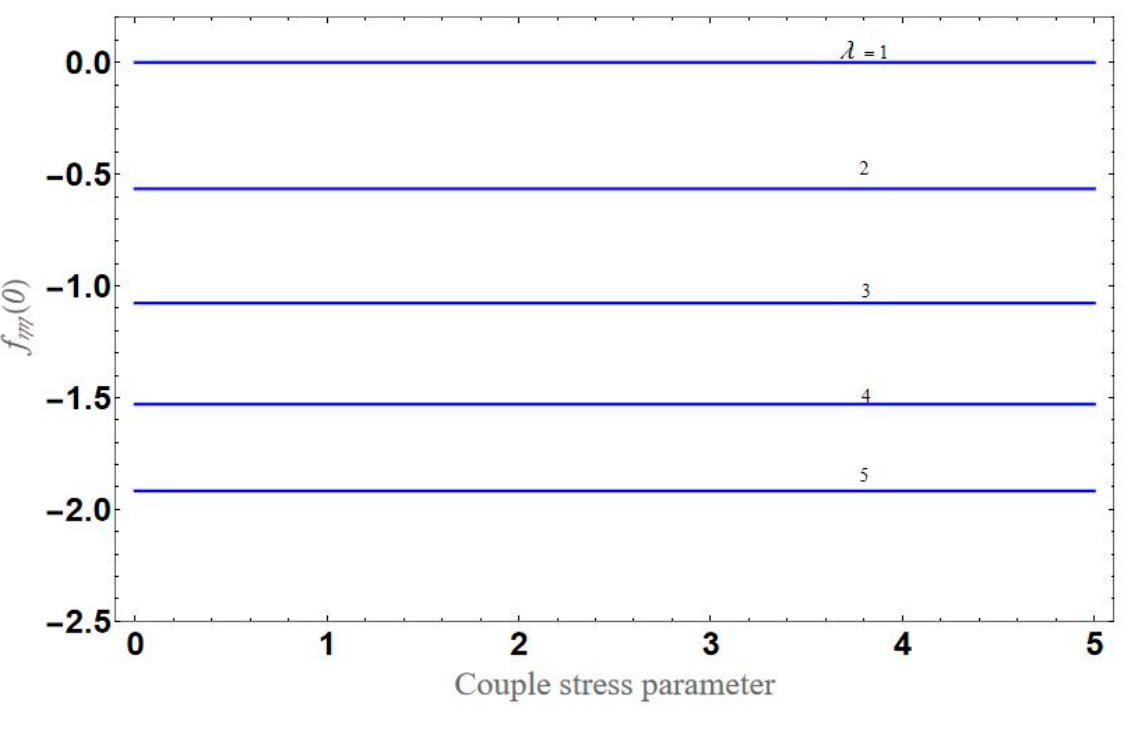
1/2 Re C with respect to couple stress for different values of λ . Figure 17. Variation of C f Re x 1/2 with respect to couple stress for different values of λ . f x